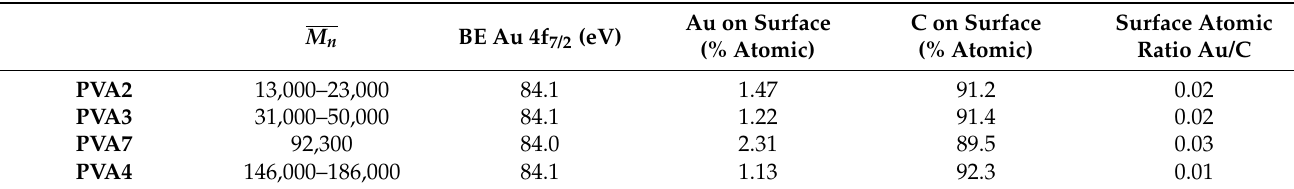
Table 3. X-ray photoelectron spectroscopy (XPS) data for 1% wt. Au/activated carbon (AC) synthesized using PVA-99 with different molecular weights.